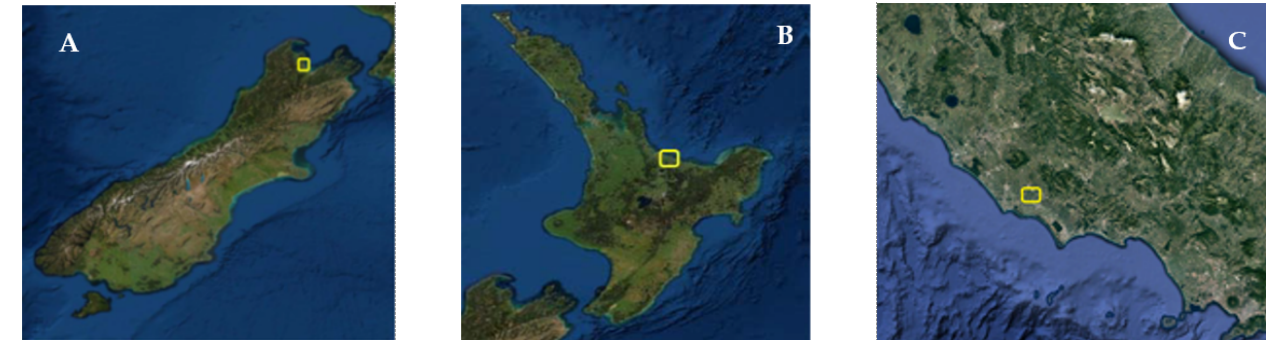
Figure 2. Study areas in New Zealand: Takaka region ( A )-Te Puke region ( B) , and in Italy: Cisterna di Latina ( C ).